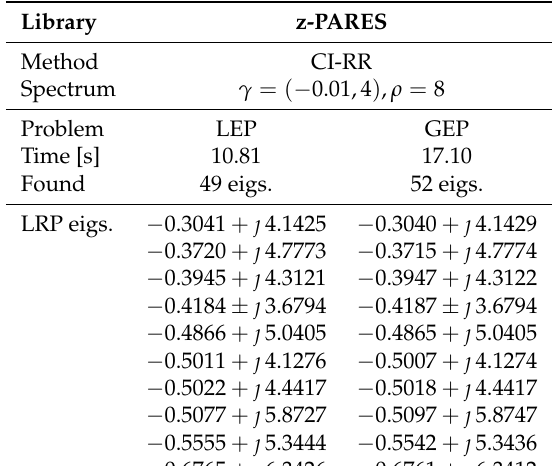
Table 11. AIITS: contour integration method, LEP and GEP.